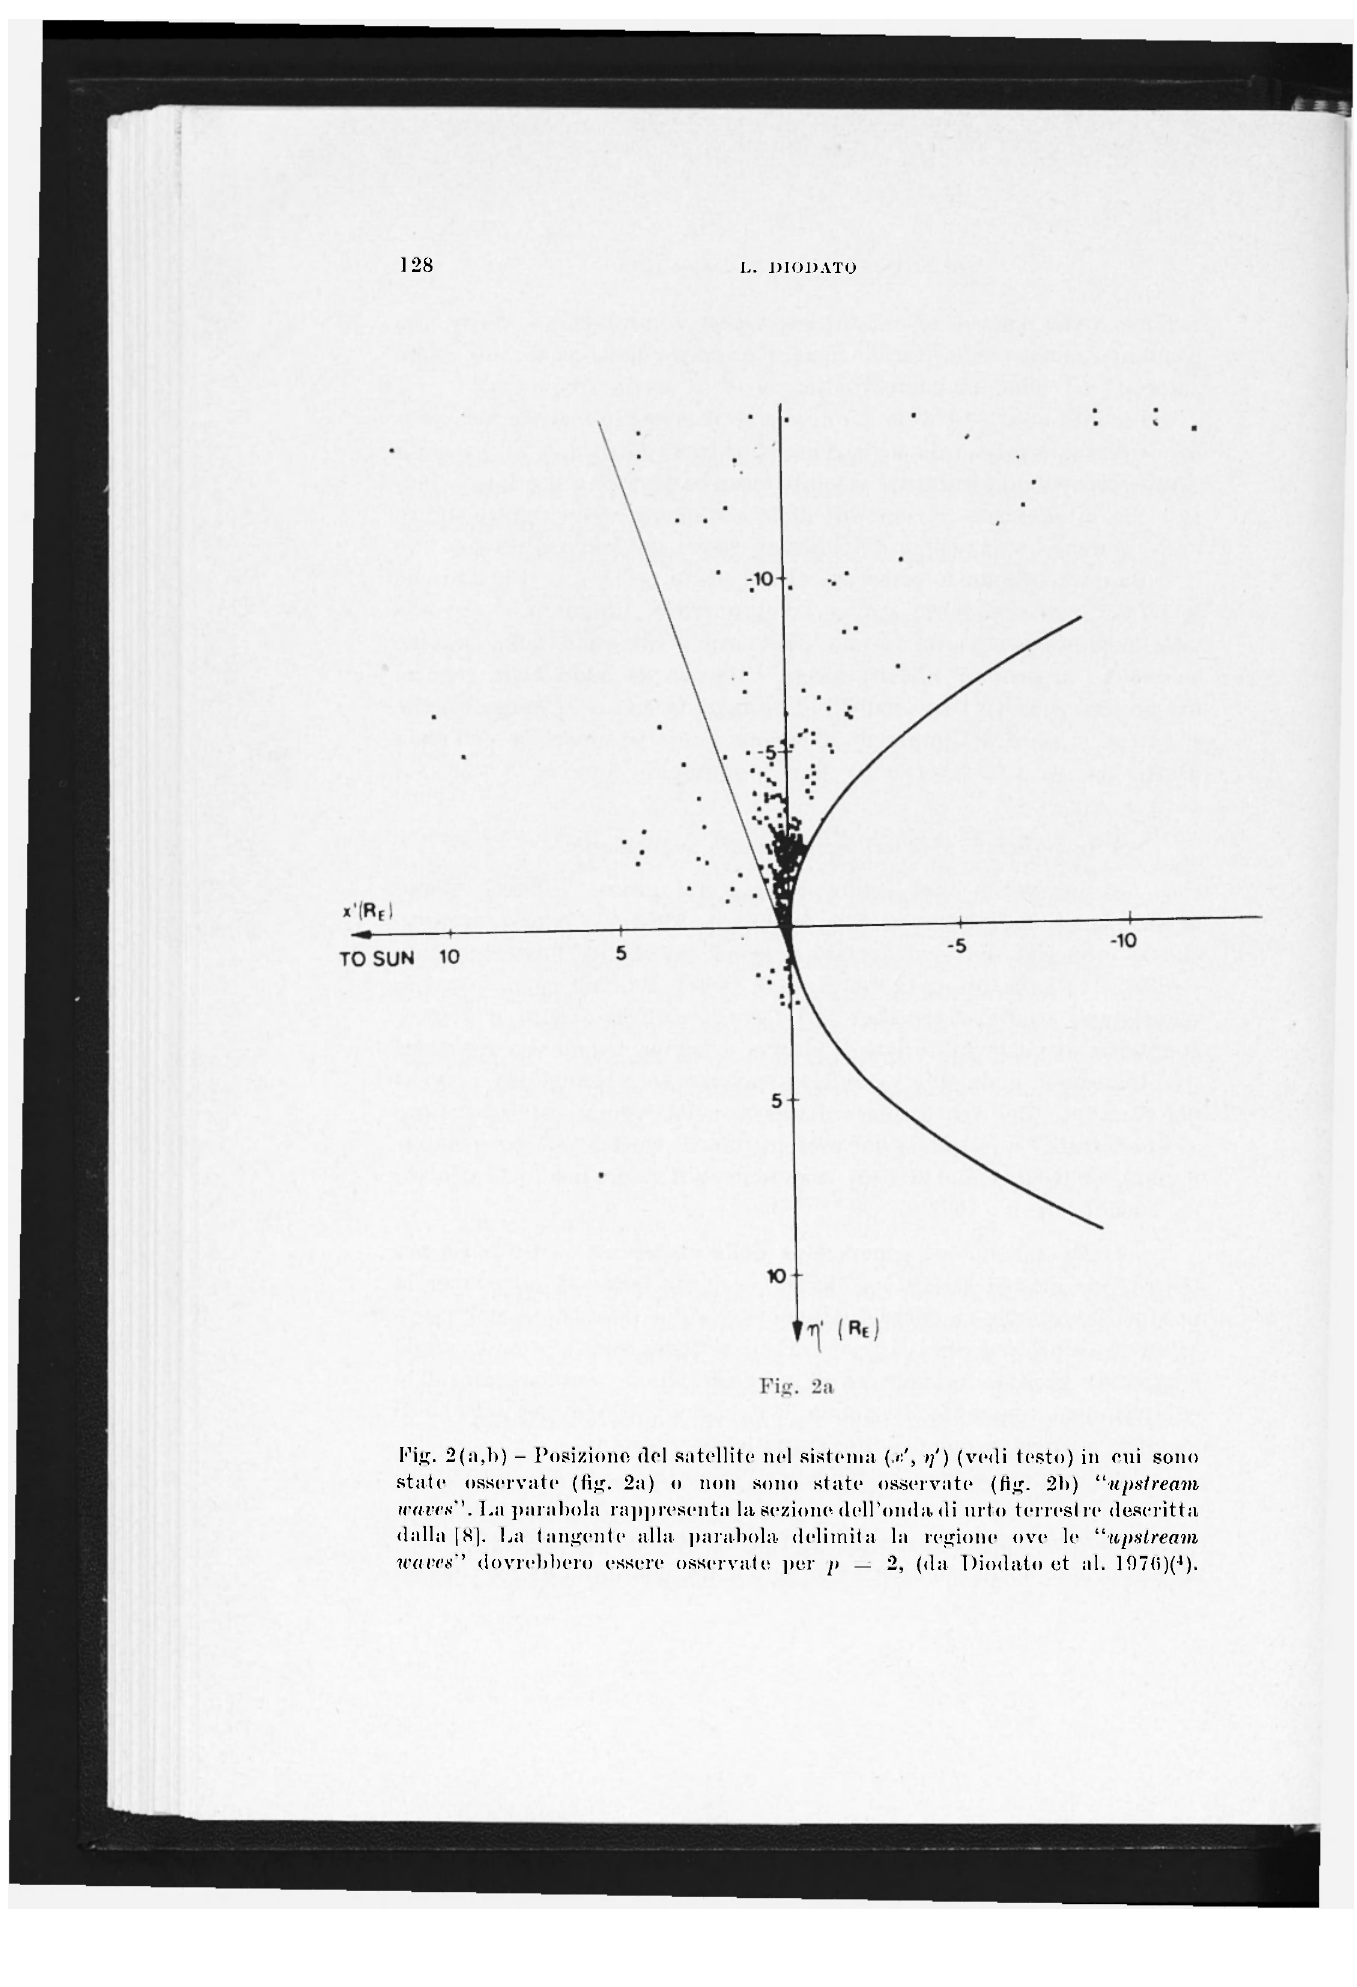
Fig. 2(a,b) - Posiziono del satellite nel sistema (.<;', rf) (vedi testo) in cui sono state osservate (fig. 2a) o non sono state osservate (fig. 2b) "upstream waves". La parabola rappresenta la sezione dell'onda di urto terrestre descritta dalla [8]. La tangente alla parabola delimita la regione ove lo " upstream waves " dovrebbero essere osservate per p — 2, (da Diodato et al. 1976)( 4